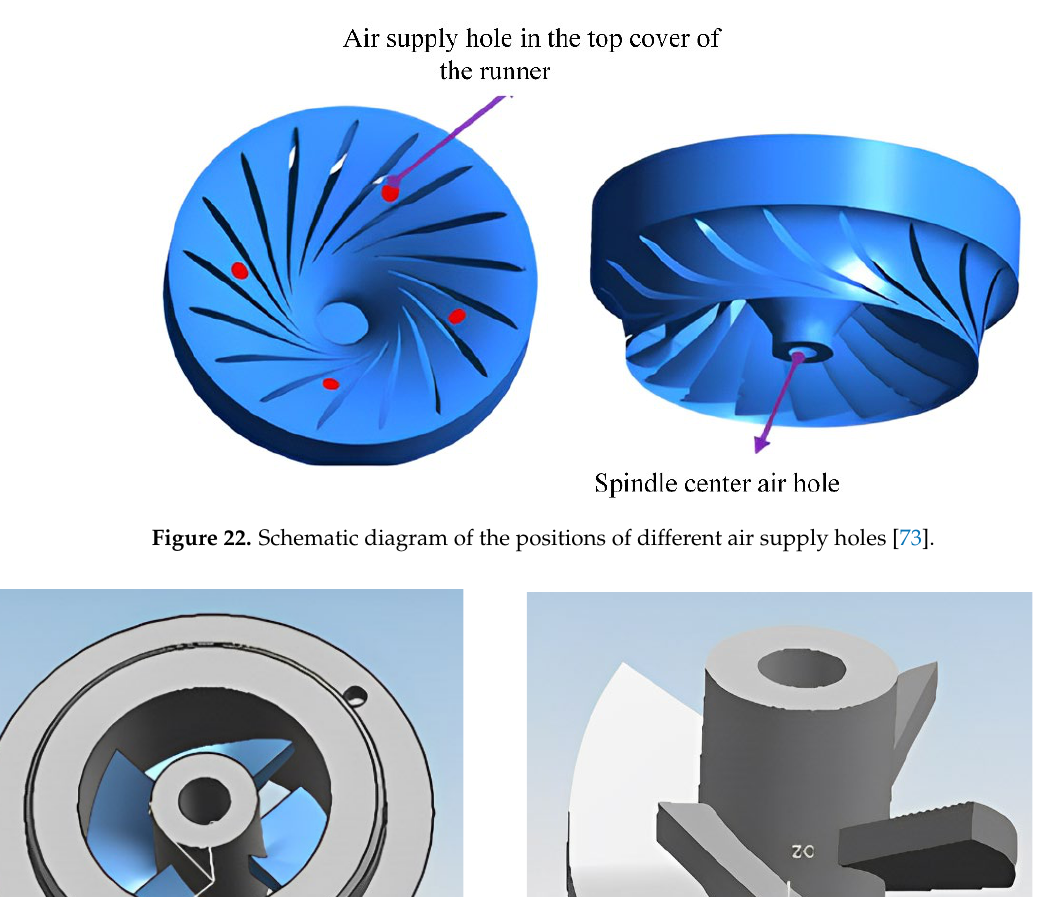
Figure 21. The shape of the vortex rope under different air supply volumes [77].